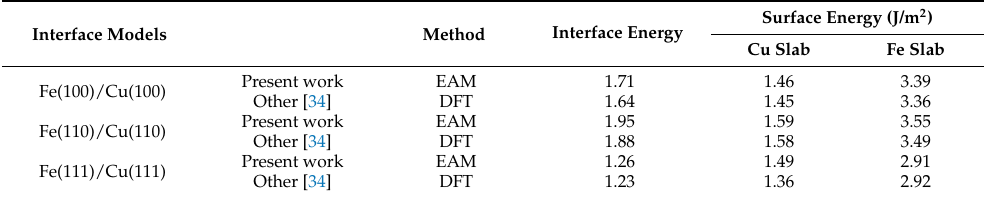
Table 2. Calculated surface energy and interface energy of Fe/Cu interface system with Fe-Cu-Ni EAM in comparison with other available data.